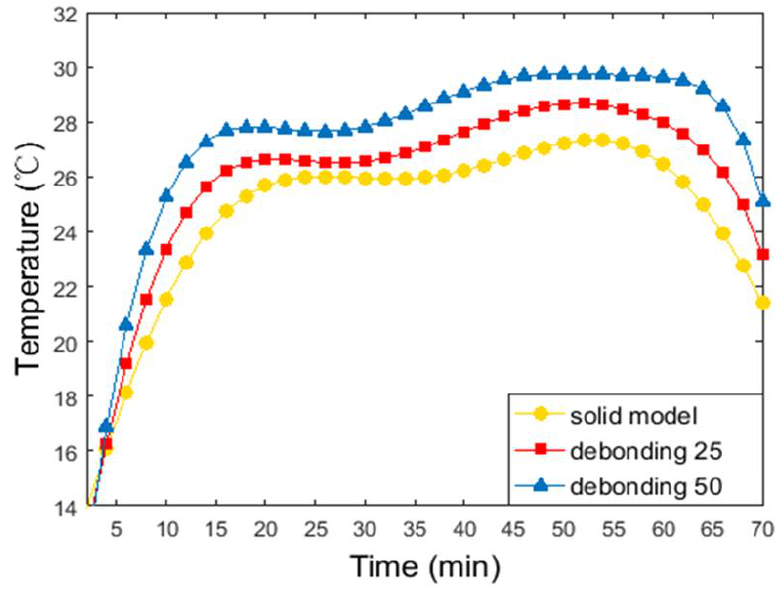
Figure 16. Temperature history of point 1.